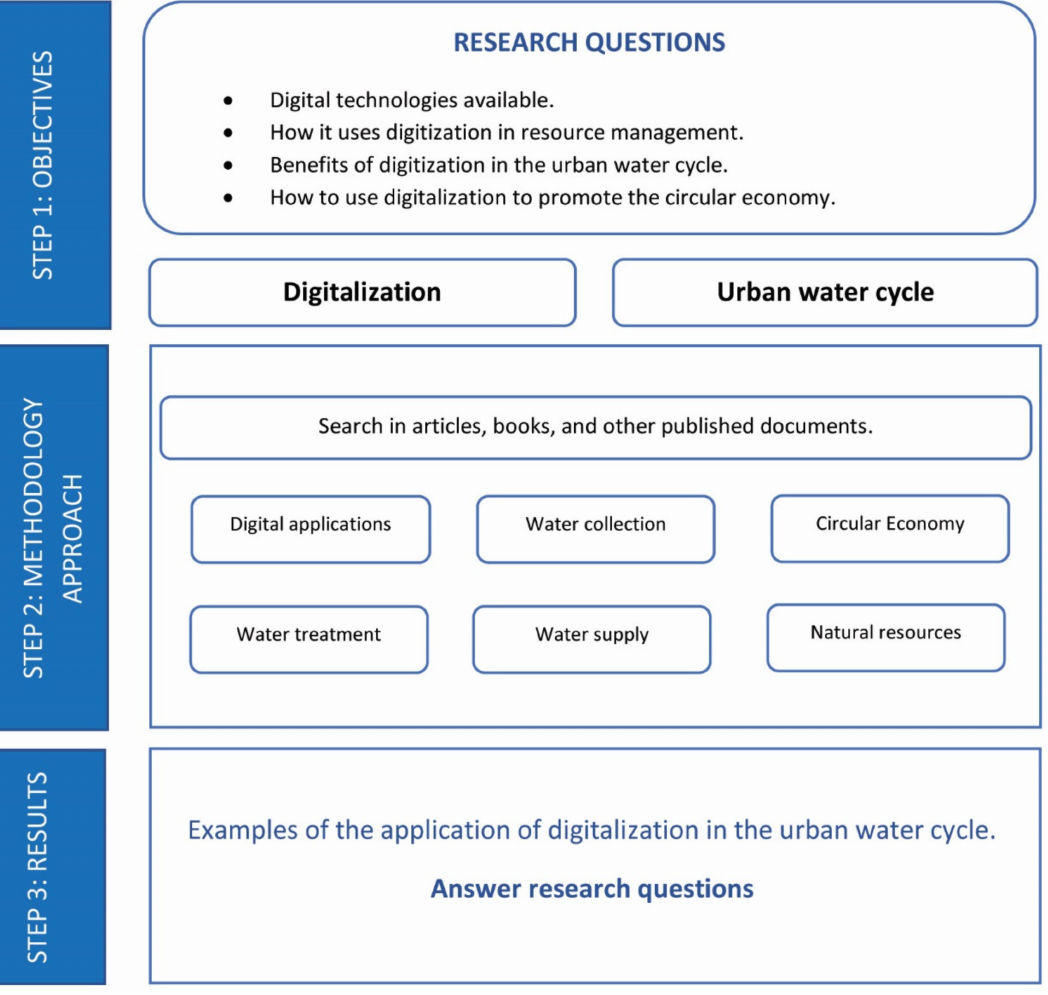
Figure 1. Methodological flow